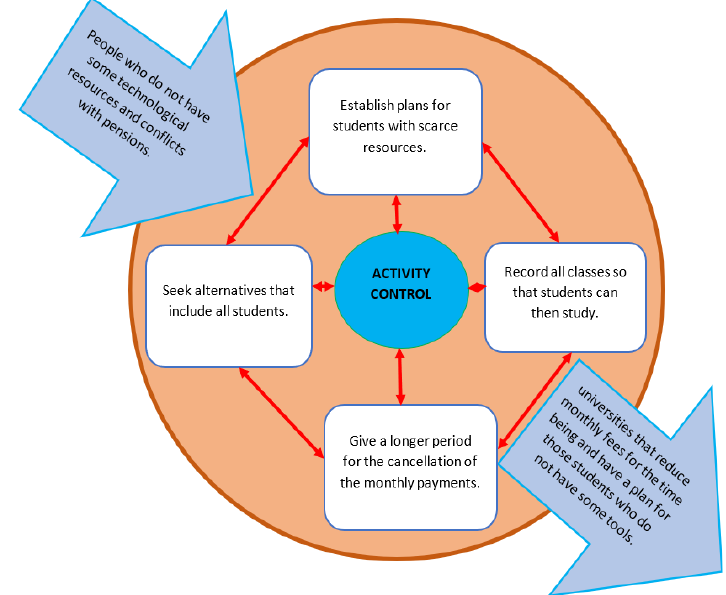
Fig. 15. Conceptual model applied to